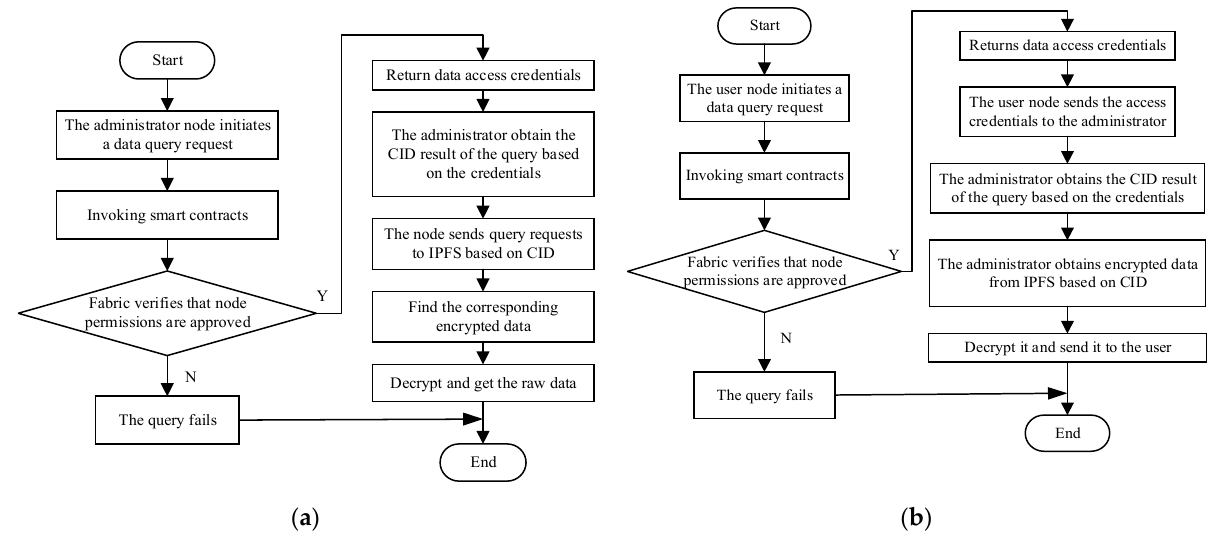
Figure 5. Data query process: (a) Flow chart of the administrator querying the data (b) Flow chart of user query data.